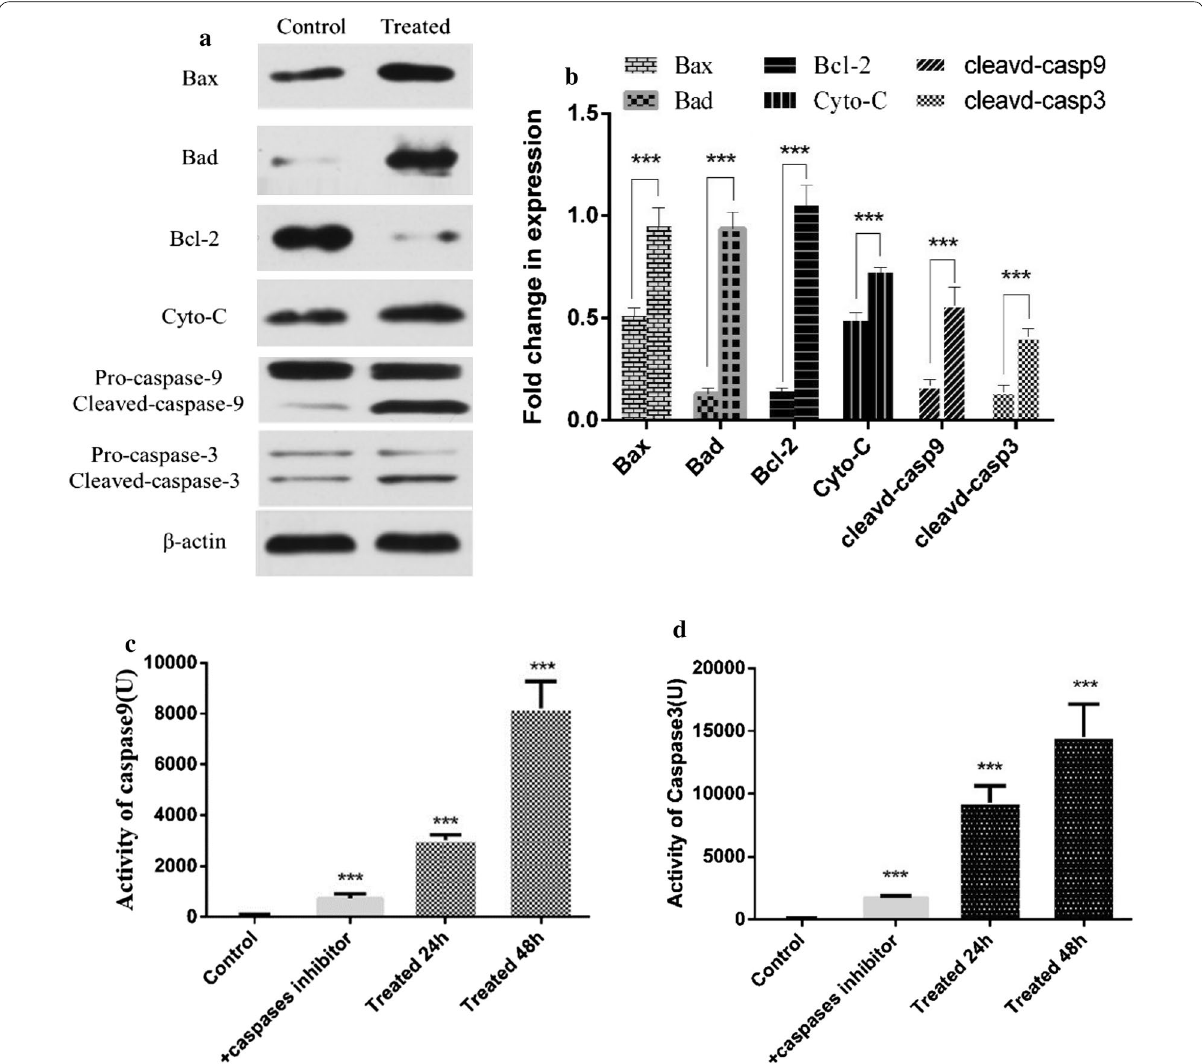
Fig. 8 The expression of apoptosis-related key proteins and the activities of caspase-9 and caspase-3. a , b Western blot analysis was carried out after 48 h without ( a ) and with ( b ) treatment of 65.76 μM lipopeptide. c , d The activity was measured at different period with or without